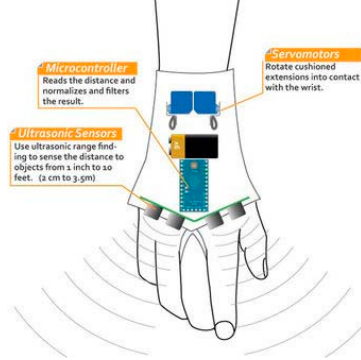
Figure 22. The proposed system attached on silicon glove [45].